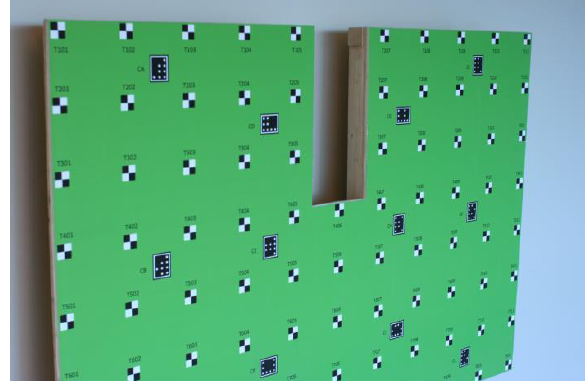
Figure 2. Photo of the stationary test field